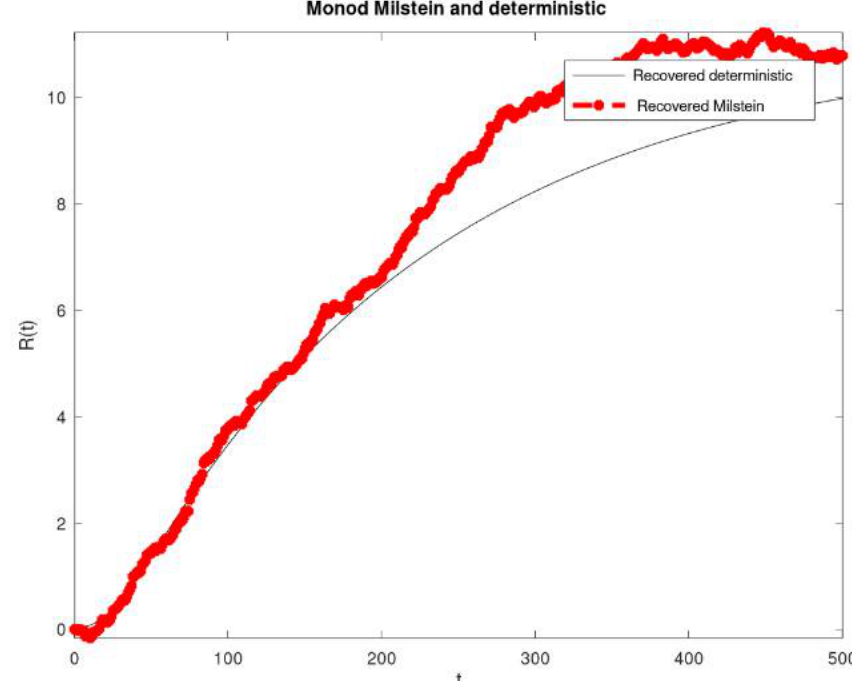
Figure 2. Plot of the dynamic behaviors of the susceptible and infected populations under the intervals (cid:101) β = 0.01 and (cid:101) γ = 0.01 .